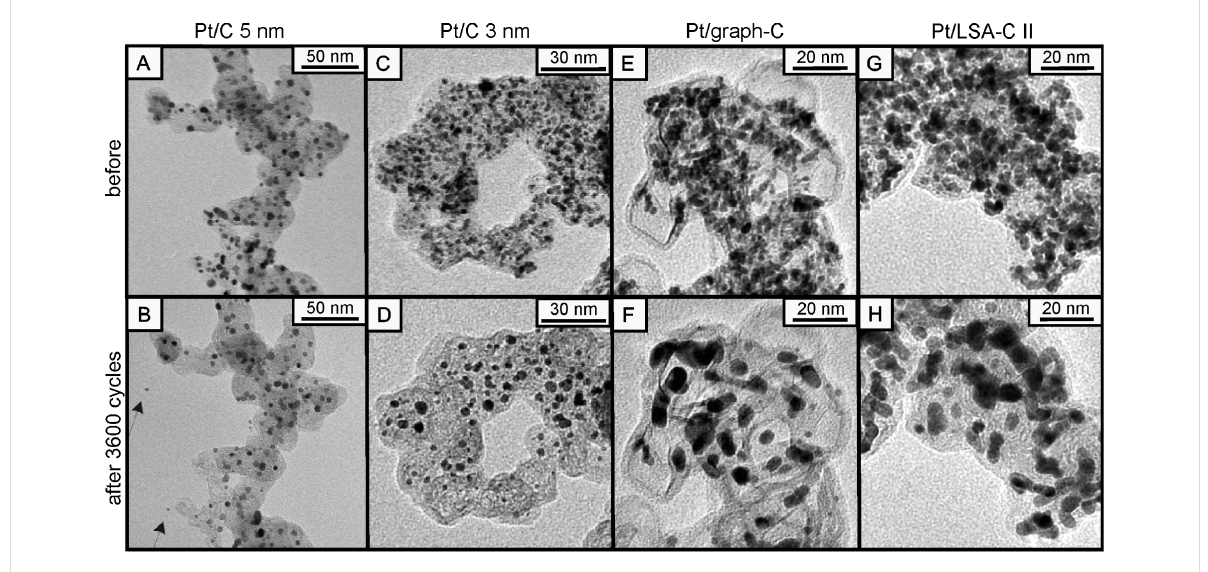
Figure 9: IL-TEM micrographs from degradation studies on four Pt/C fuel cell catalysts. Pt/C 5 nm (A,B) and Pt/C 3nm (C,D) are the same catalysts as depicted in Table 1 and Figure 2. Pt/graph-C (E,F) is a catalyst with graphitized carbon support and Pt/LSA-C II (G,H) is a catalyst with a (tran- sition-metal modified) low surface area support. More information about these and further catalysts can be found in Table 2. A), C), E) and G) depict the catalysts before potential cycling, while B), D), F) and H) are micrographs of the identical locations after 3600 potential cycles between 0.4 and 1.4 V RHE (scan rate 1 V·s − 1 ; 0.1 M HClO 4 , room temperature). A) and B) were reprinted from [52] with permission; Copyright 2008 Elsevier. C)–F) were reproduced from [67] with permission; Copyright 2012 The Electrochemical Society. G) and H) were kindly provided by Arenz and